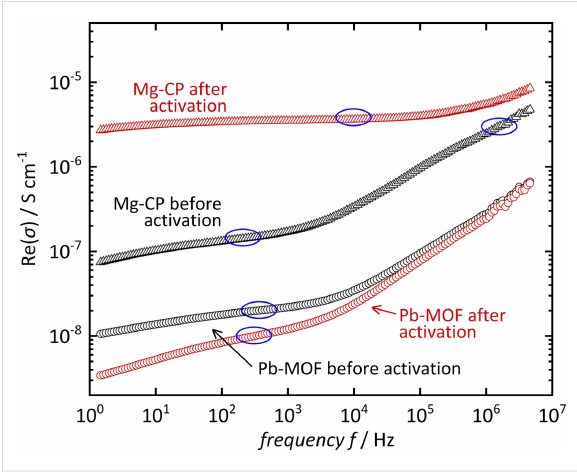
Figure 5: Real parts of the conductivity values of [Mg(H 2 O) 2 (H 3 L)]·H 2 O and [Pb 2 (HL)]·H 2 O obtained by conversion of impedance into permittivity (22 °C, 90% r.h.). Highlighted regions (blue) correspond to the values obtained from the Nyquist plots (see Table